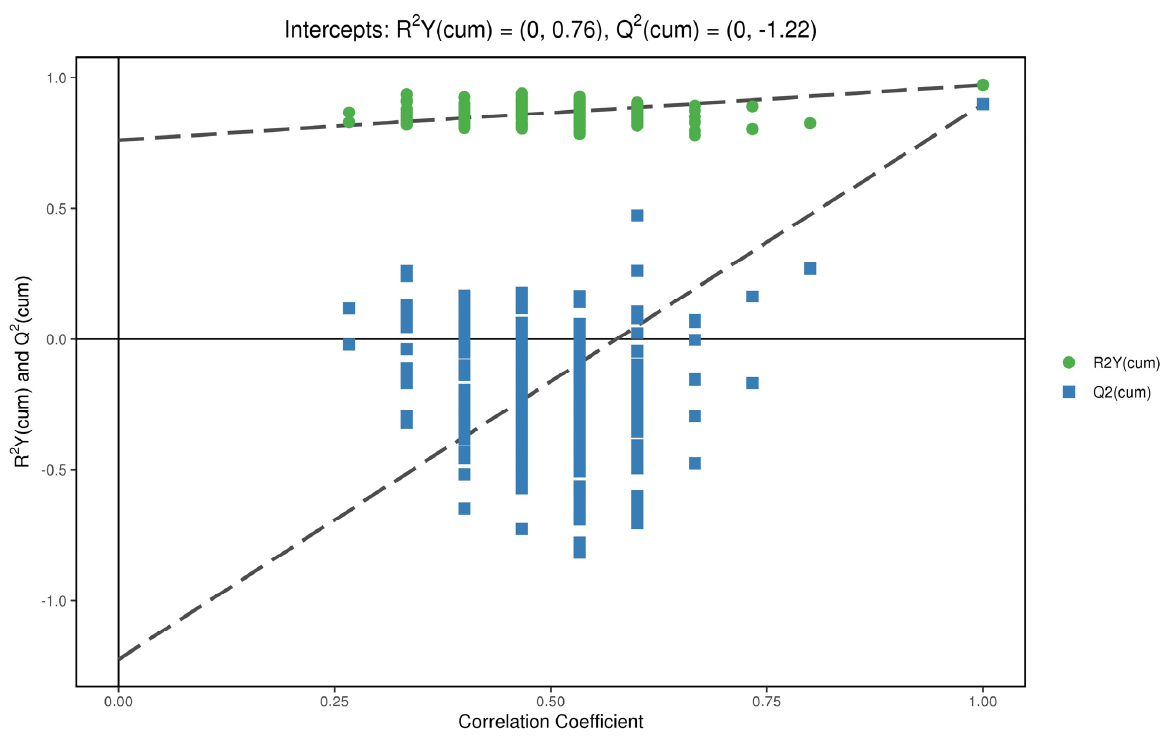
Figure 9. Displacement test chart of positive ions.